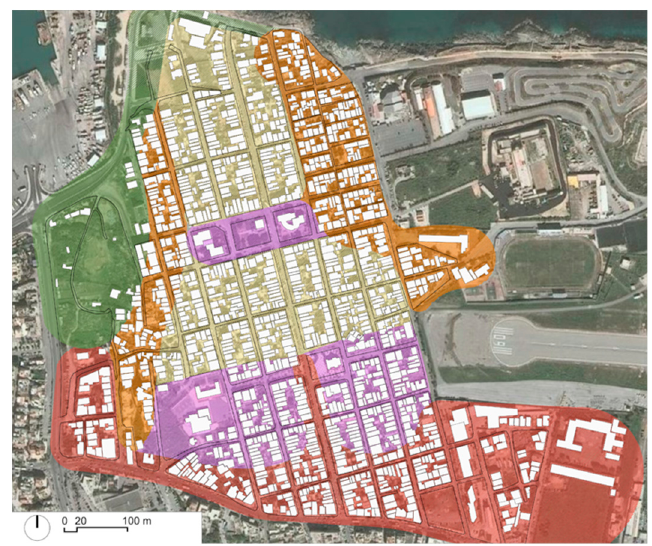
Figure 7. Heraklion—Five different sound identities in Alikarnassos district: the beach ( green ), the shopping area ( red ), the residential ( yellow ), urban squares ( purple ), small village ( orange ) [11].